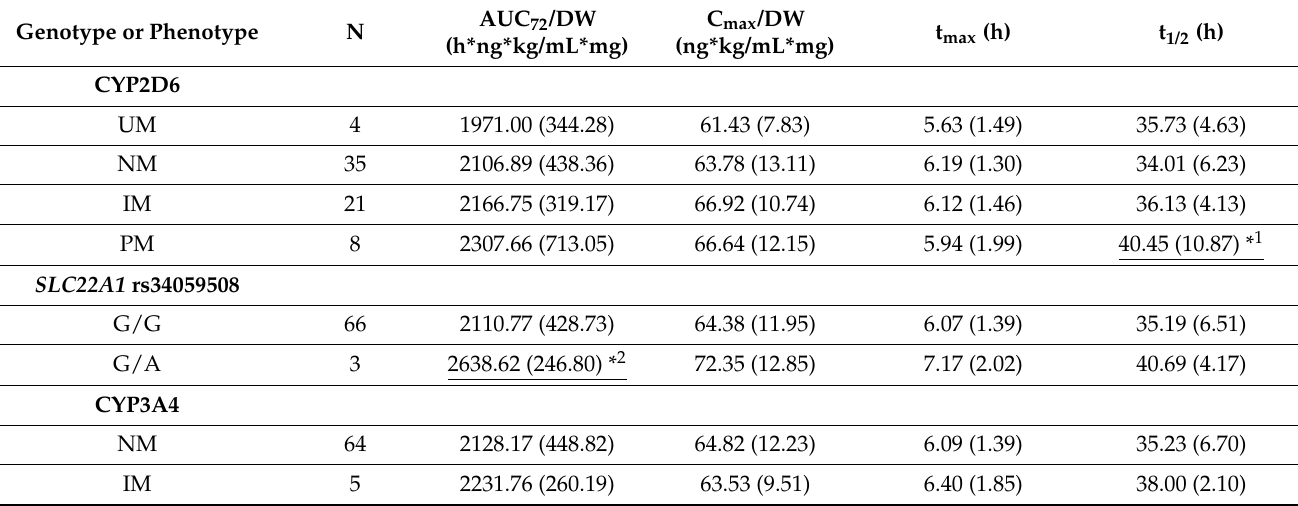
Table 4. Pharmacokinetic parameters according to CYP3A4 phenotype and genotypes or phenotypes showing statistically significant associations in the exploratory